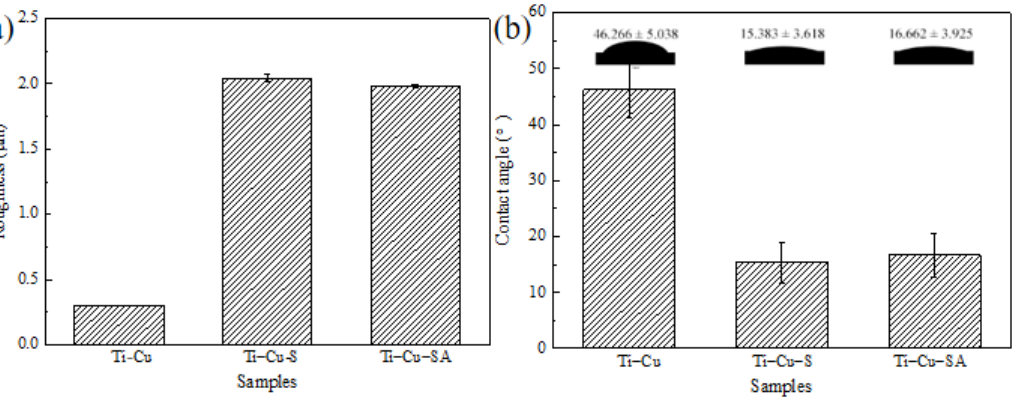
Figure 2. Roughness and water contact angle of the Ti-Cu alloys ( a ) roughness; ( b ) water contact angle.